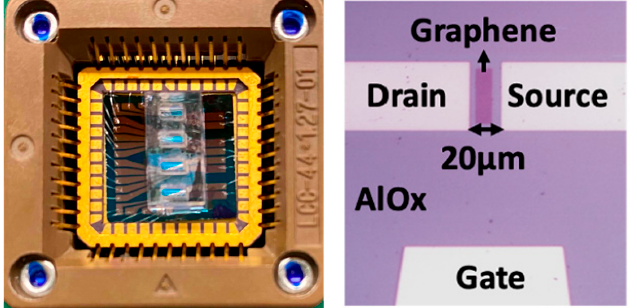
Figure 8. ( Left ) A G-FET chip (1.2 cm × 1.2 cm) with 4 PDMS wells. ( Right ) Microscopic image of a single G-FET with source–drain and side gate electrode and graphene-sensing window with AlOx passivation [61]. Reused and adapted with permission from the American Chemical Society.